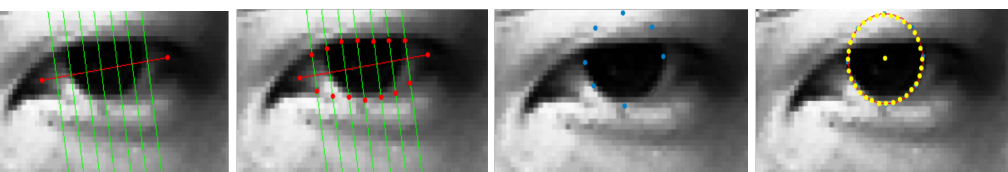
Figure 9. From left to right presents the sequential labeling process. The red and green lines and blue dots are tools for landmark coordinates, and the red and yellow dots represent annotations. Outputs are comprised of 16 eye edges, 32 iris edges, 1 eye center, and 1 iris